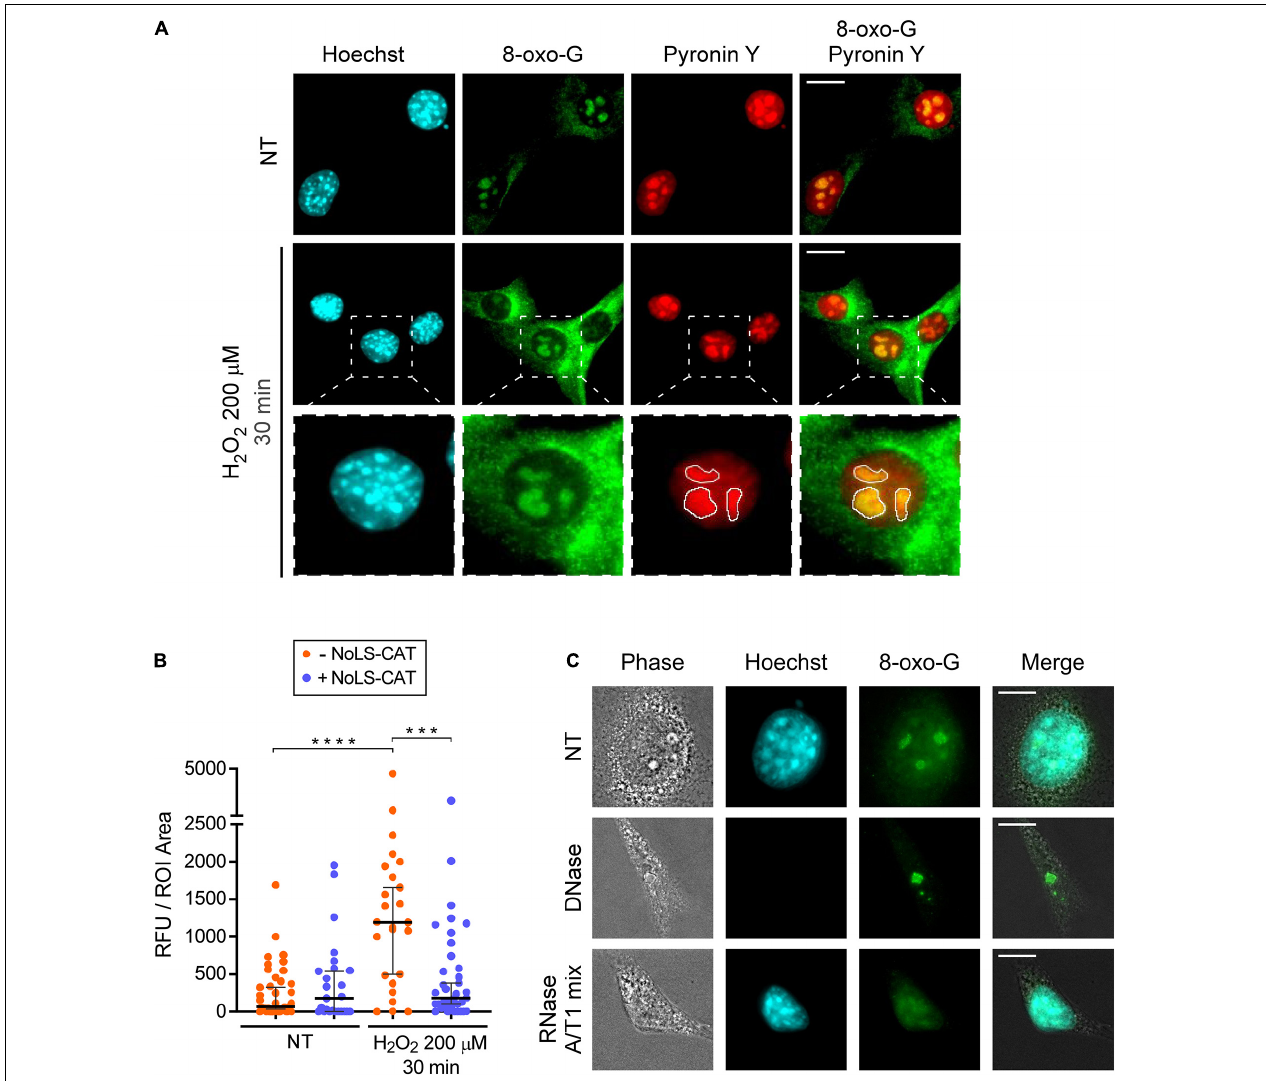
FIGURE 3 | H 2 O 2 increases 8-oxo-G in nucleolar RNA. (A) Microscopic analysis of DNA (Hoechst 33342 signal), RNA (pyronin Y signal) and 8-oxo-G (immunostaining with the monoclonal 15A3 antibody). Representative images are shown for cells not treated with H 2 O 2 (basal oxidation levels) and cells treated with 200 µ M H 2 O 2 for 30 min. The white lines in the bottom row demarcate nucleolar ROIs based on the pyronin Y signal. For an example of a wider field, see Supplementary Figure 3 . (B) NoLS-CAT confers protection from an increase in nucleolar 8-oxo-G caused by H 2 O 2 exposure. n = 39, 25, 25, 27 individual nucleoli analyzed (from left to right), the horizontal center line represents the median, error bars indicate 95% CI. Mann-Whitney test was used for pairwise comparisons. **** P < 0.0001, *** P < 0.001 (two-tailed values). (C) Representative images of cells subjected to DNase or RNase treatments (NT, non-treated control). Note that for the enzymatic treatments, cells are permeabilized with detergents prior to their fixation, accounting for the cells’ collapsed appearance in the resulting images. After fixation, cells were stained with anti-8-oxo-G antibody. Hoechst staining visualizes DNA in the nucleus. For an example of a wider field, see Supplementary Figure 4 . Scale bars, 10 µ